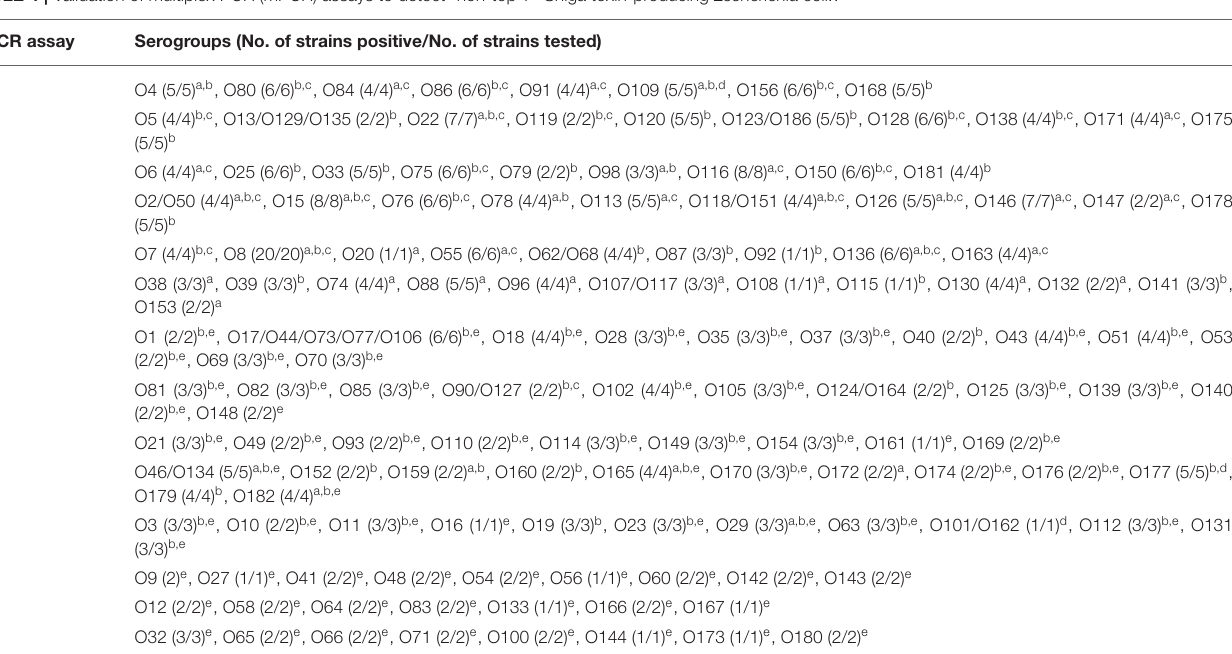
TABLE 4 | Validation of multiplex PCR (mPCR) assays to detect “non-top-7” Shiga toxin-producing Escherichia coli. . mPCR